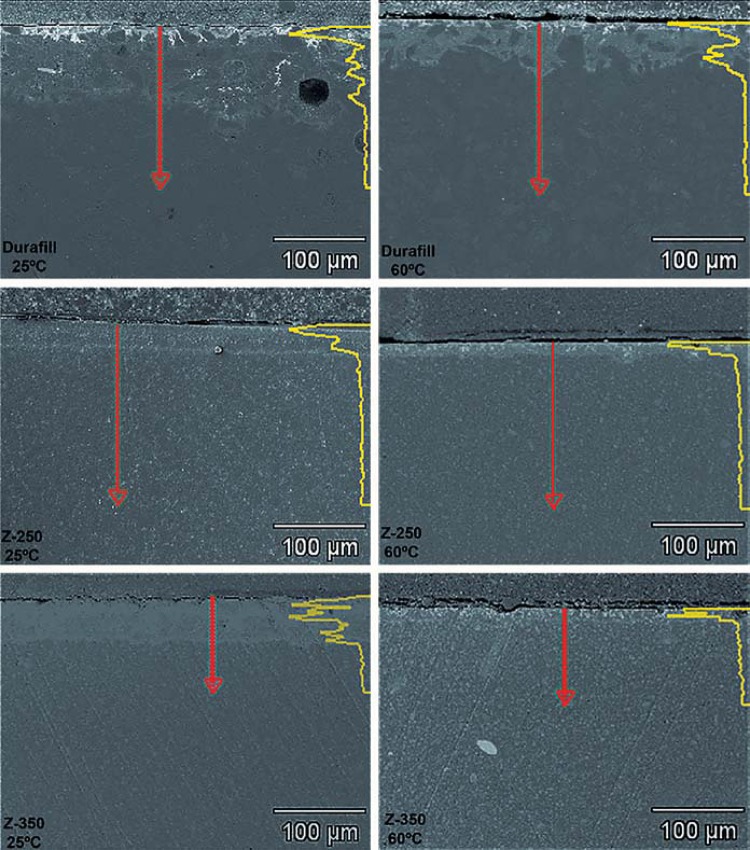
Patterns of silver penetration obtained via linear analysis with EDS, in association with different temperatures and composites. The length of the waved portion of the yellow line determines the depth of silver penetration. Red arrows indicate the direction of the quantitative digital linear scanning across each specimen’s surface